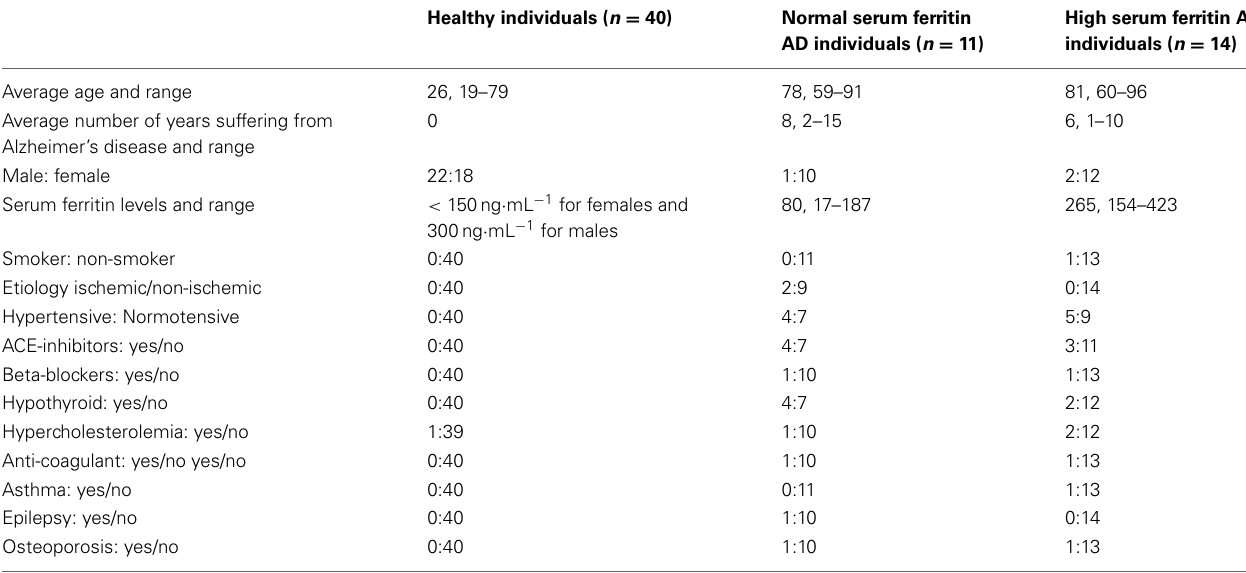
Table 2 | Summary characteristics of healthy individuals and Alzheimer’s disease individuals.